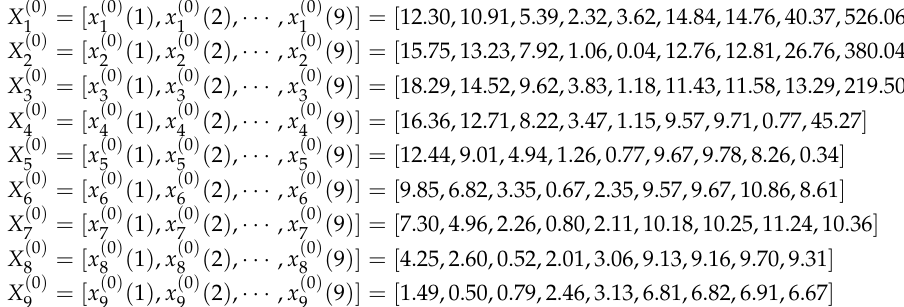
versus time ( b ) Graph of cumulative vertical displacement versus time.